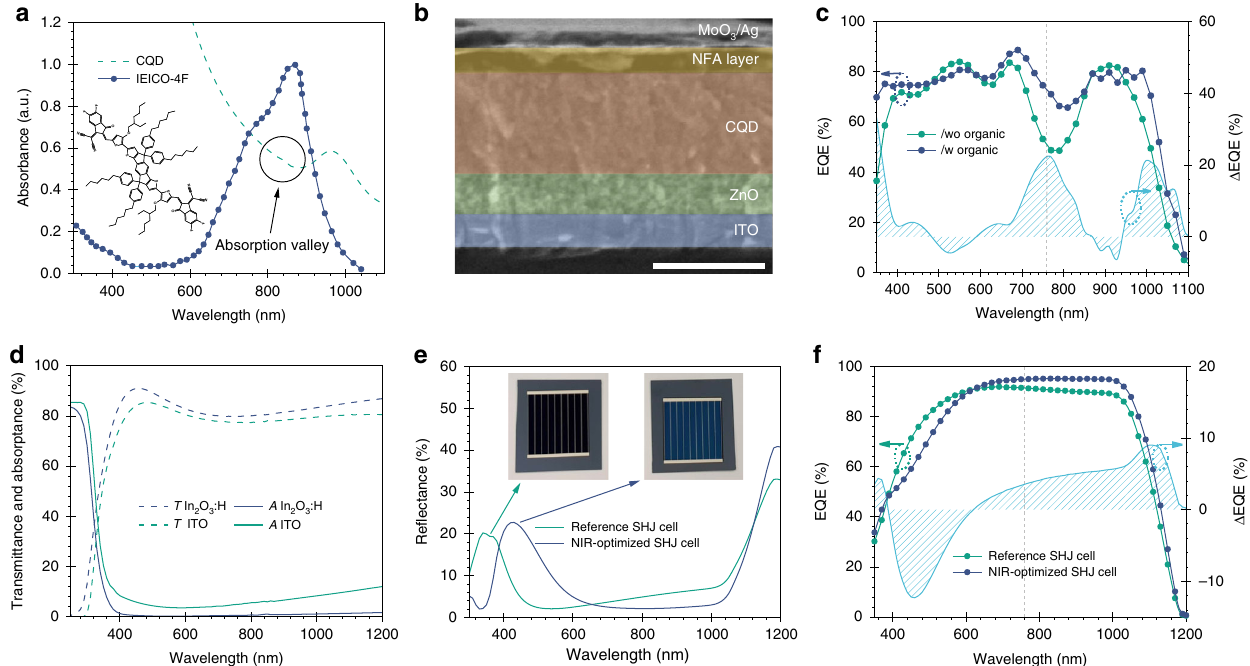
Fig. 5 NIR-tailored design for bottom cells. a Molecular structure and absorbance spectrum of NFA. The symbol line denotes the absorbance of CQD. b Cross-sectional SEM image of fully solution-processed CQD bottom cell. Scale bar: 500 nm. c EQE spectra of CQD device without and with the organic layer. d Transmission (dashed) and absorption (solid) of In 2 O 3 :H and standard ITO fi lms. e Re fl ection and f EQE spectra of reference and NIR-optimized SHJ cell. Short dashed lines indicate the bandedge cut-off of perovskite front cell.